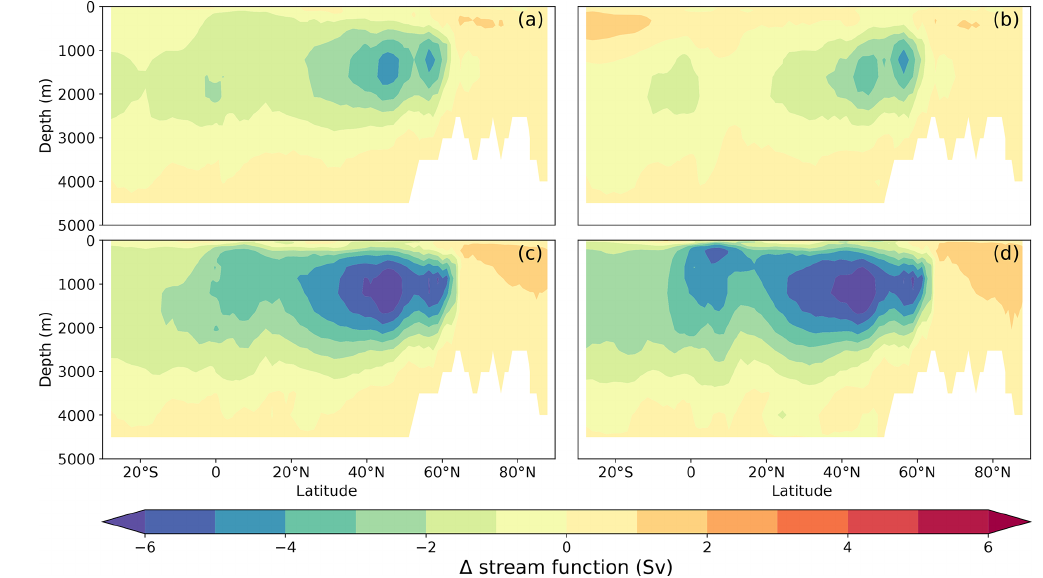
Figure B2. Stream function difference between future scenarios (2041–2070) and historical simulation (1976–2005) for the NDJFM season. The future scenarios are (a) RCP8.5, (b) WAIS3m, (c) GrIS1m and (d) GrIS3m.